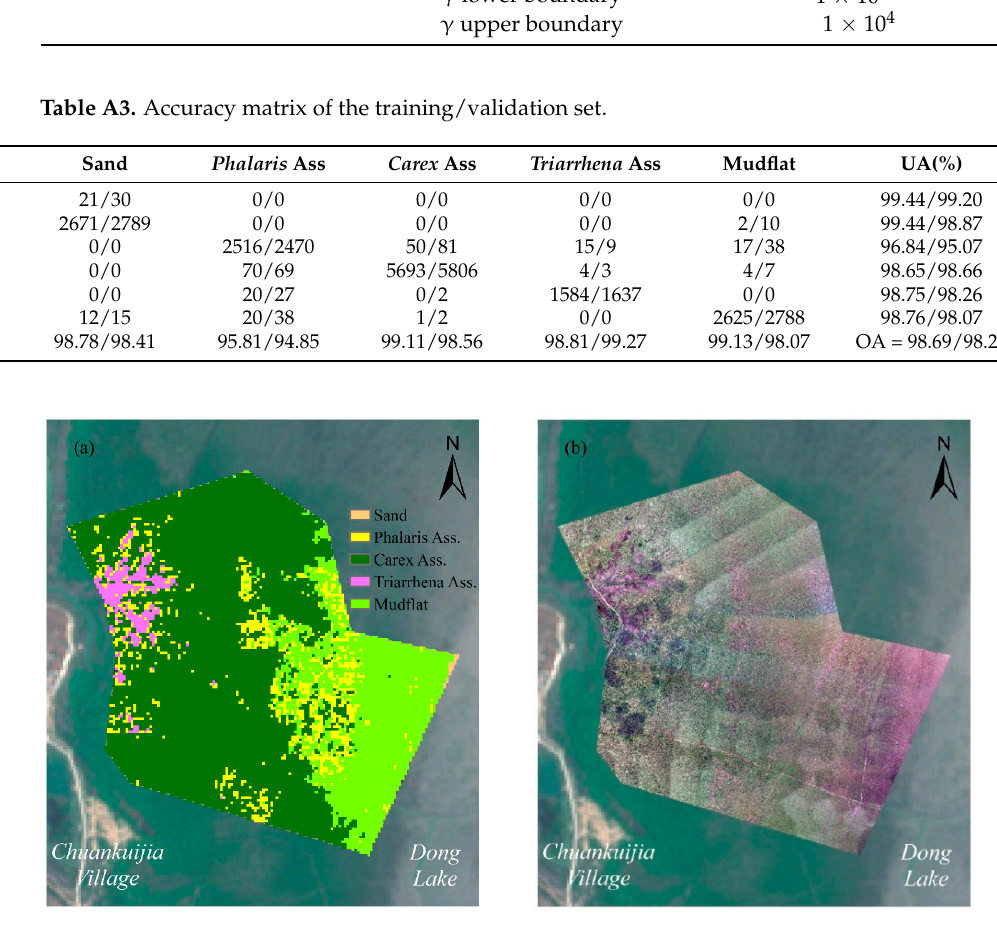
Figure A1. Simulation of ( a ) the wetland herbaceous communities’ distribution and ( b ) a drone RGB image in Chuankuijia village.